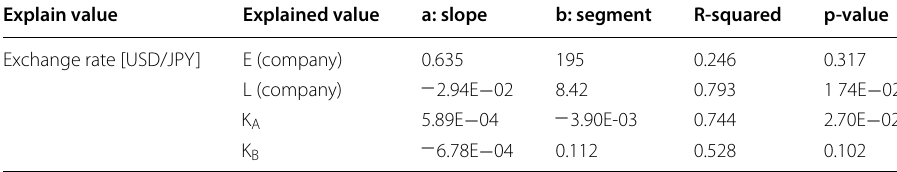
Table 2 Estimated linear models on the indexes Explain